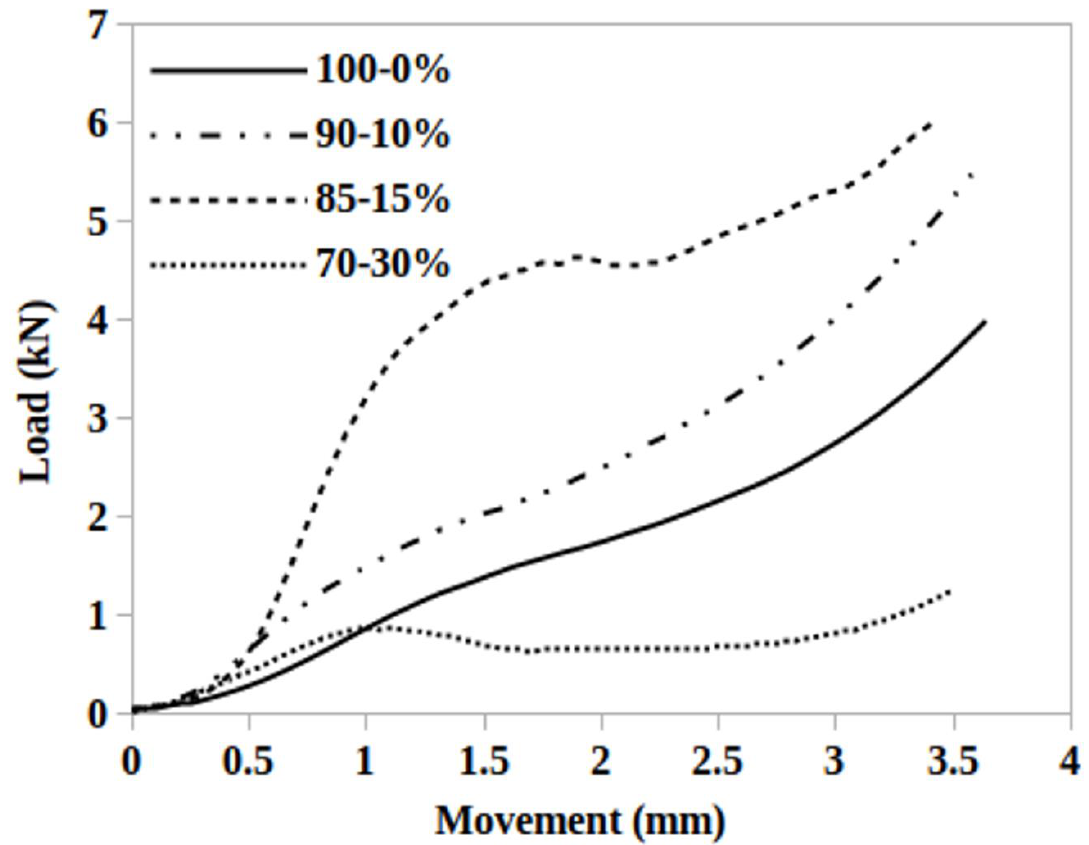
Figure 3. Variation of the load as a function of the displacement.